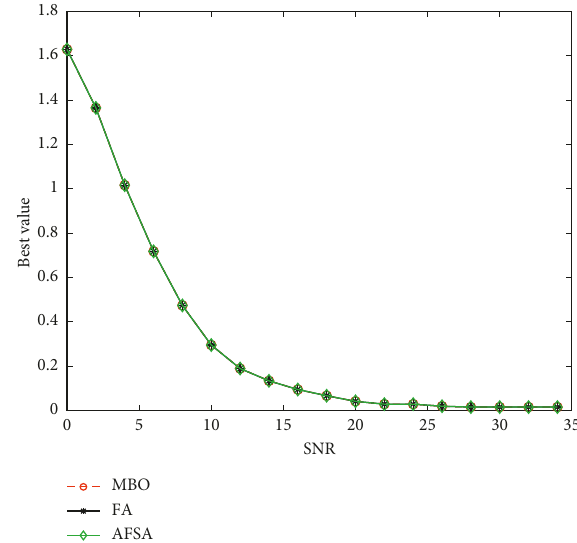
Figure 6: System performance comparison of the three